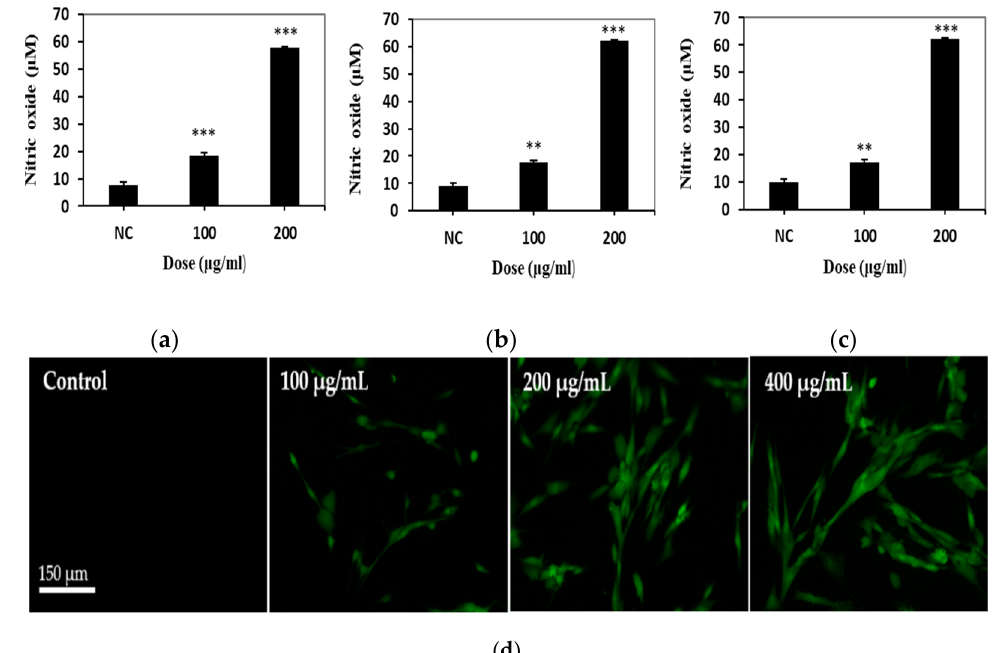
Figure 3. Diesel exhaust particle-induced NO/reactive oxygen species (ROS) production. Changes in nitric oxide levels, after exposure to DEP (0–200 µg/mL) for ( a ) 24 h, ( b ) 48 h, and ( c ) 72 h in WI-38 cells. Statistically significant difference is indicated by ** p < 0.01 and *** p < 0.001 when compared with the negative control. Values are means of triplicate measurements. NC: negative control. Intracellular ROS production following treatment with DEP ( d ). Incubation with various concentrations of DEP (100–400 µg/mL) increased intracellular ROS production. Scale bar = 150 µm.